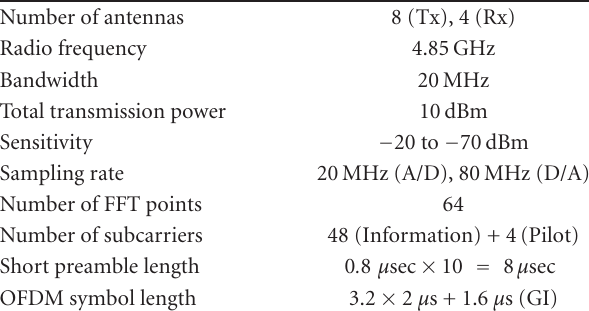
Table 1: Parameters of MIMO-OFDM